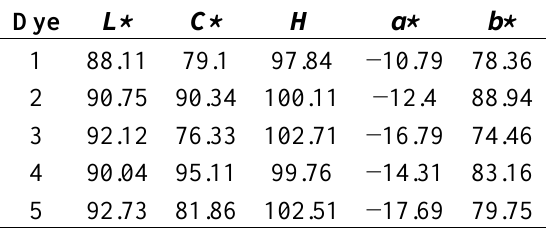
Table 3. Color coordinates of the dyed nylon